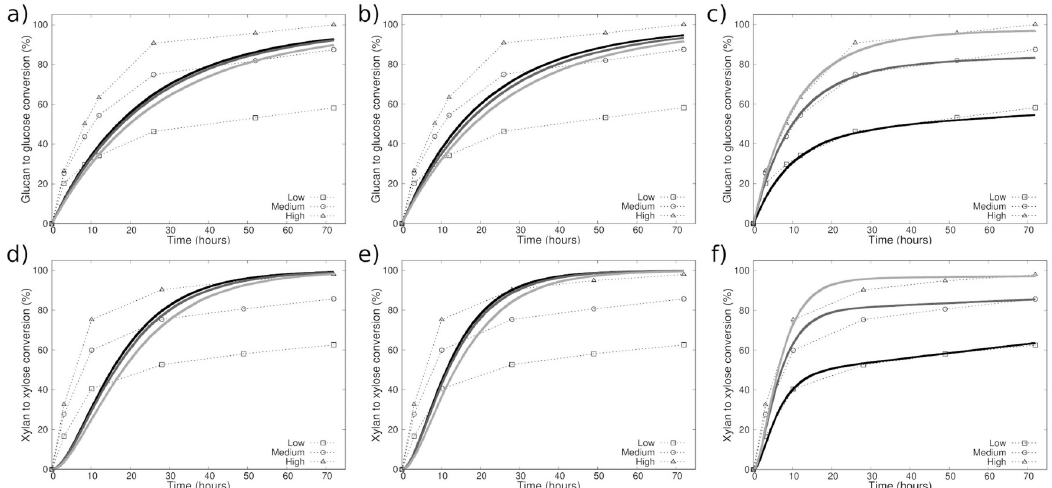
Fig 9. Experimental data (dotted lines) and best simulation fits of the saccharification time courses for three different pre- treatment severities (low: Black lines, medium: Dark grey lines, high: Light grey lines). (a) and (d) The substrate has no structure and all polymers are freely floating within the medium. (b) and (e) The cellulose polymers form a microfibril, which is surrounded by hemicellulose and lignin. However, the crystallinity of the substrate is discarded. (c) and (f) The substrate crystallinity is additionaly included, which substantially improves the fits. Each curve represents an average over 100 simulation runs. The experimental data shown here are from Bura et al. [11].